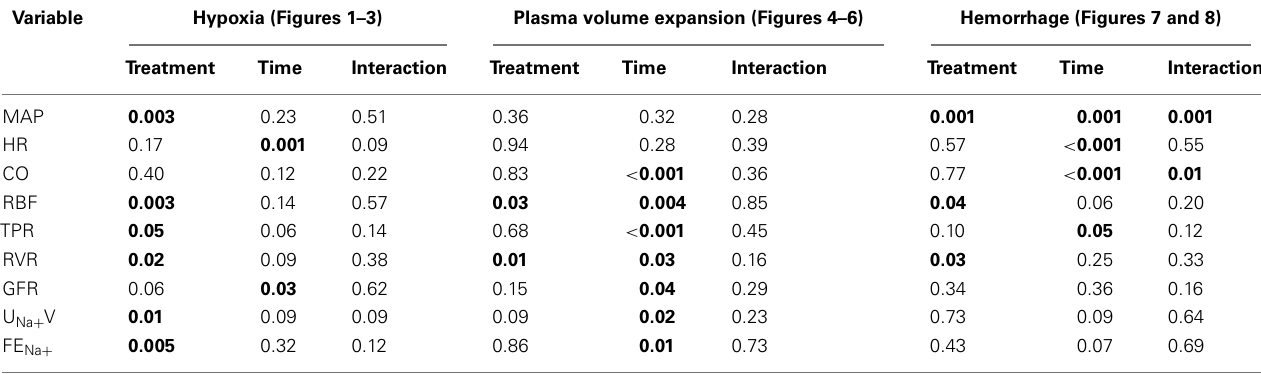
Table 2 | Outcomes of two-way repeated measures analysis of variance for data shown in Figures 2, 3, and 5–8.